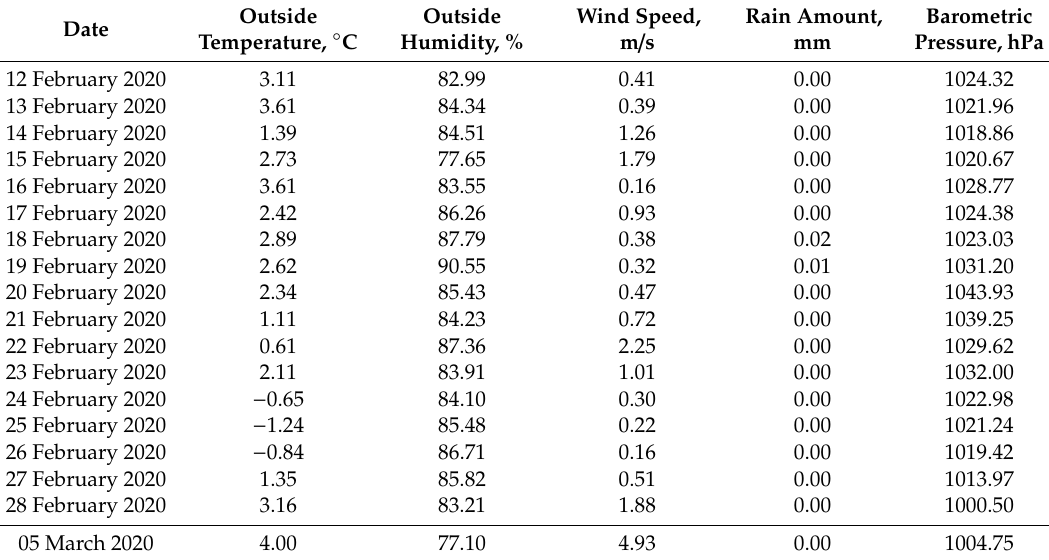
Table 2. Weather data from a local meteorological